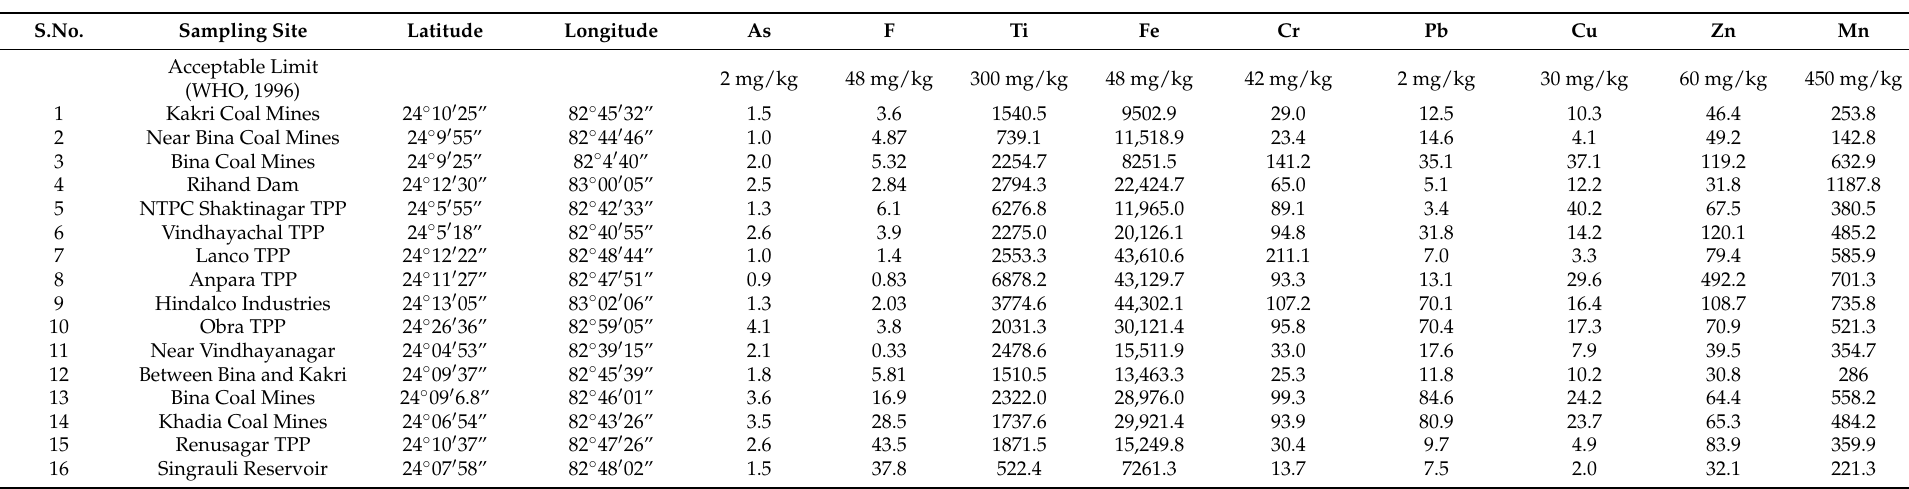
Table 3. Soil sampling location in the study area and concentration of arsenic, fluoride, titanium, chromium, copper, lead, zinc, and manganese.